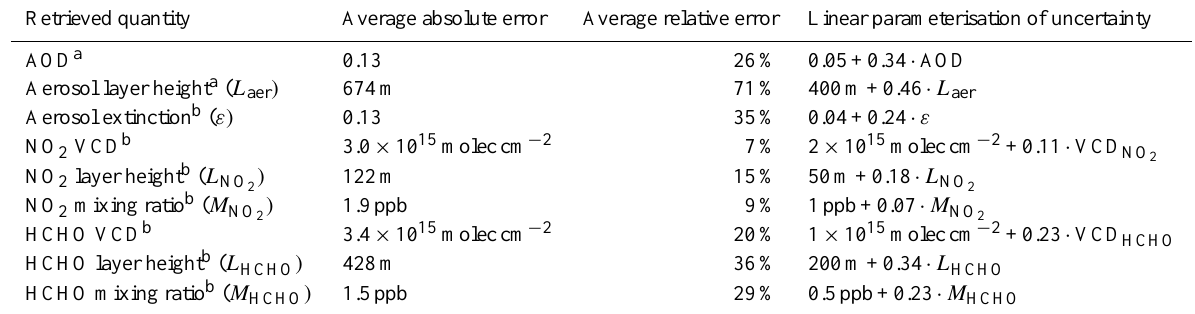
a Determined for a two-layer profile with a shape parameter of 1.1. b Determined for a box-profile (shape parameter of